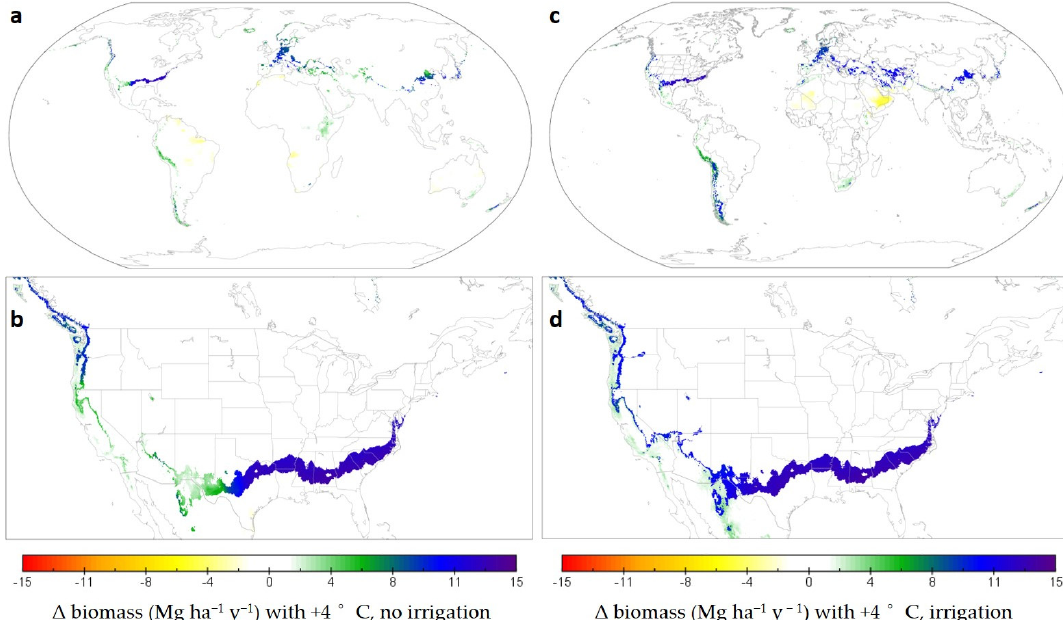
Figure 2. Projected change in potential biomass production (Mg ha − 1 y − 1 ) of Agave americana with + 4 °C warming, globally ( a , c ) and in North America ( b , d ), and simulated with ( a , b ) and without ( c , d ) irrigation. In North America, A. americana yield differences from east to west are due mostly to water inputs. Biomass projections for A. americana indicate that the highest yields can be expected in the southeastern US, Caribbean islands, and the Yucatan peninsula (Figure 3) where annual rainfall amounts are high. With irrigation added (Figure 4), total potential biomass yields from A. americana increased by 93–96%, and biomass yields can reach op- timum amounts even in the arid southwestern US and western Mexico. Rock mulching can also support increased biomass yields of A. americana in the dry regions of the south- western US and western Mexico with less irrigation inputs (Figure 4).